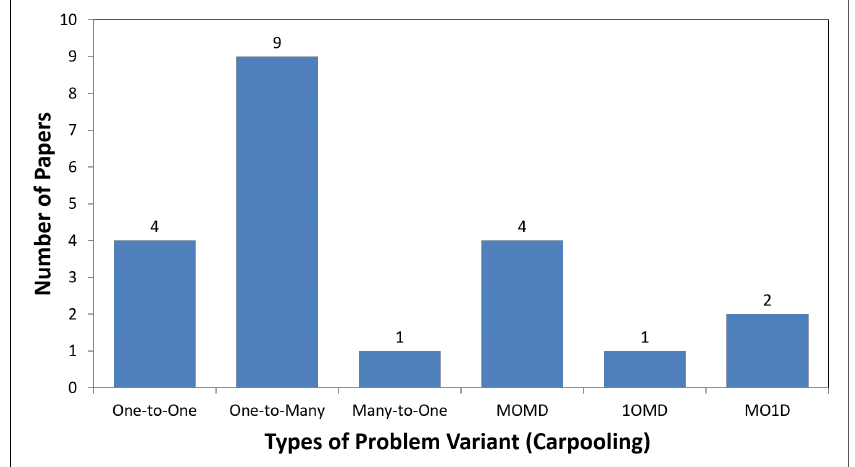
Figure 6. Distribution of Papers based on the Problem Variants: